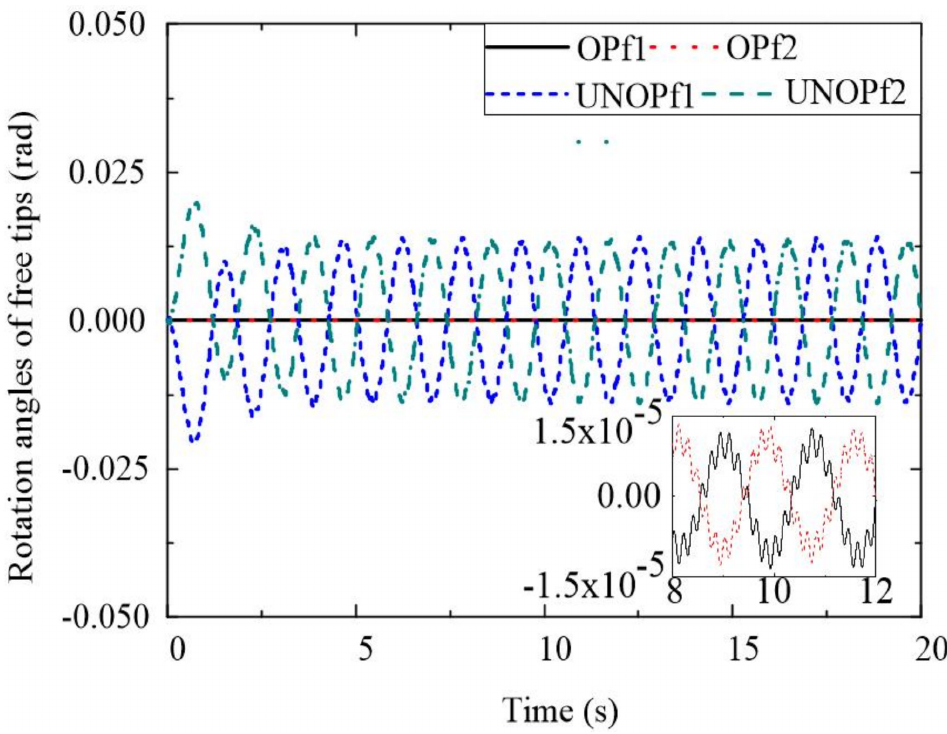
Figure 14. Rotation angles of the tips of the beams during the preassembly stage.